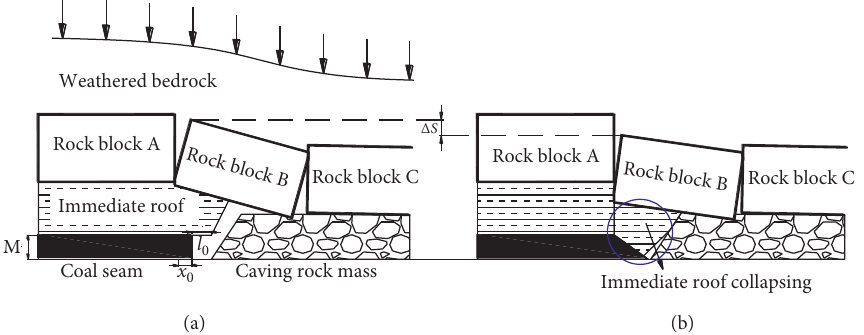
Figure 7: (a) No collapse of the immediate roof; (b) collapse of the immediate roof.